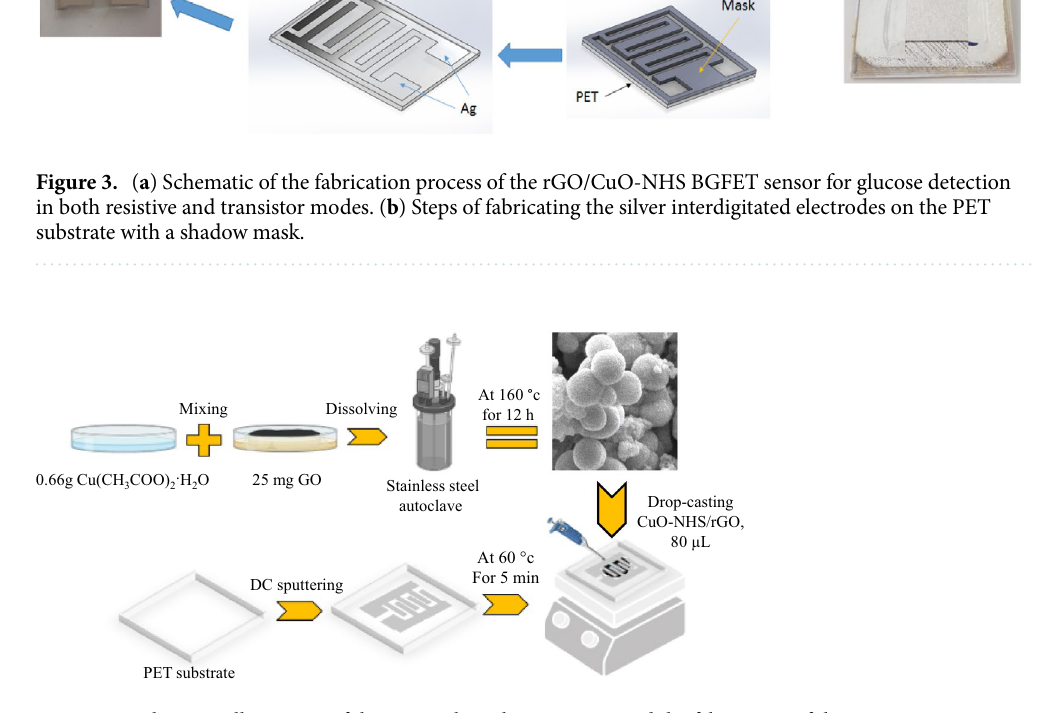
Figure 4. Schematic illustration of the material synthesis process and the fabrication of the rGO/CuO–NHS BGFET